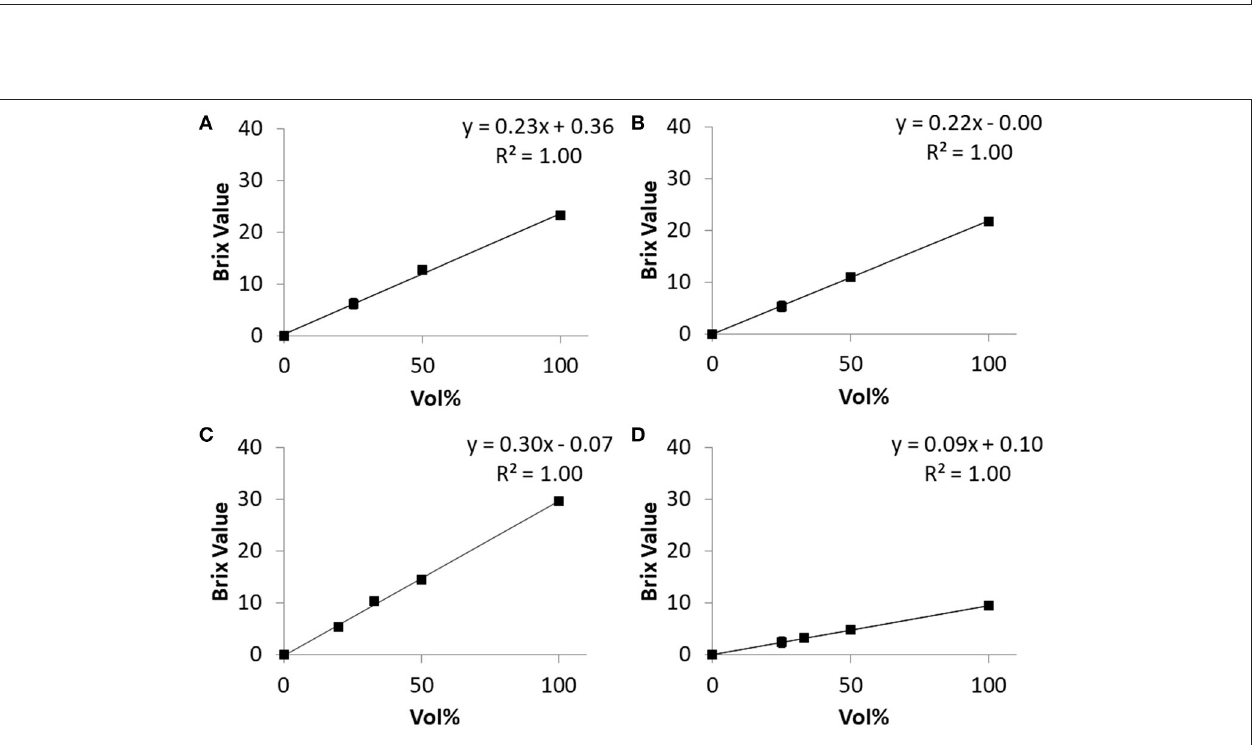
FIGURE 2 | Relations of BV and content of four different solutions obtained in vitro . (A) Osmolyte HN, (B) Fresubin original fiber, (C) Diben Drink, (D) Glucose 10%. For each solution, three different persons performed the dilution and refractometric BV-measurement. Each dot represents the mean of these three measurements. The mean normalized standard deviation over all measured concentrations greater than zero was 3.4% for Osmolyte HN, 2.7% for Fresubin Original Fiber, 3.3% for Diben Drink, and 2.4% for Glucose 10%. The normalized standard error of the slope of the regression line was 3.67% for Osmolyte HN, 0.7% for Fresubin Original Fiber, 5.0% for Diben Drink, and 1.3% for Glucose